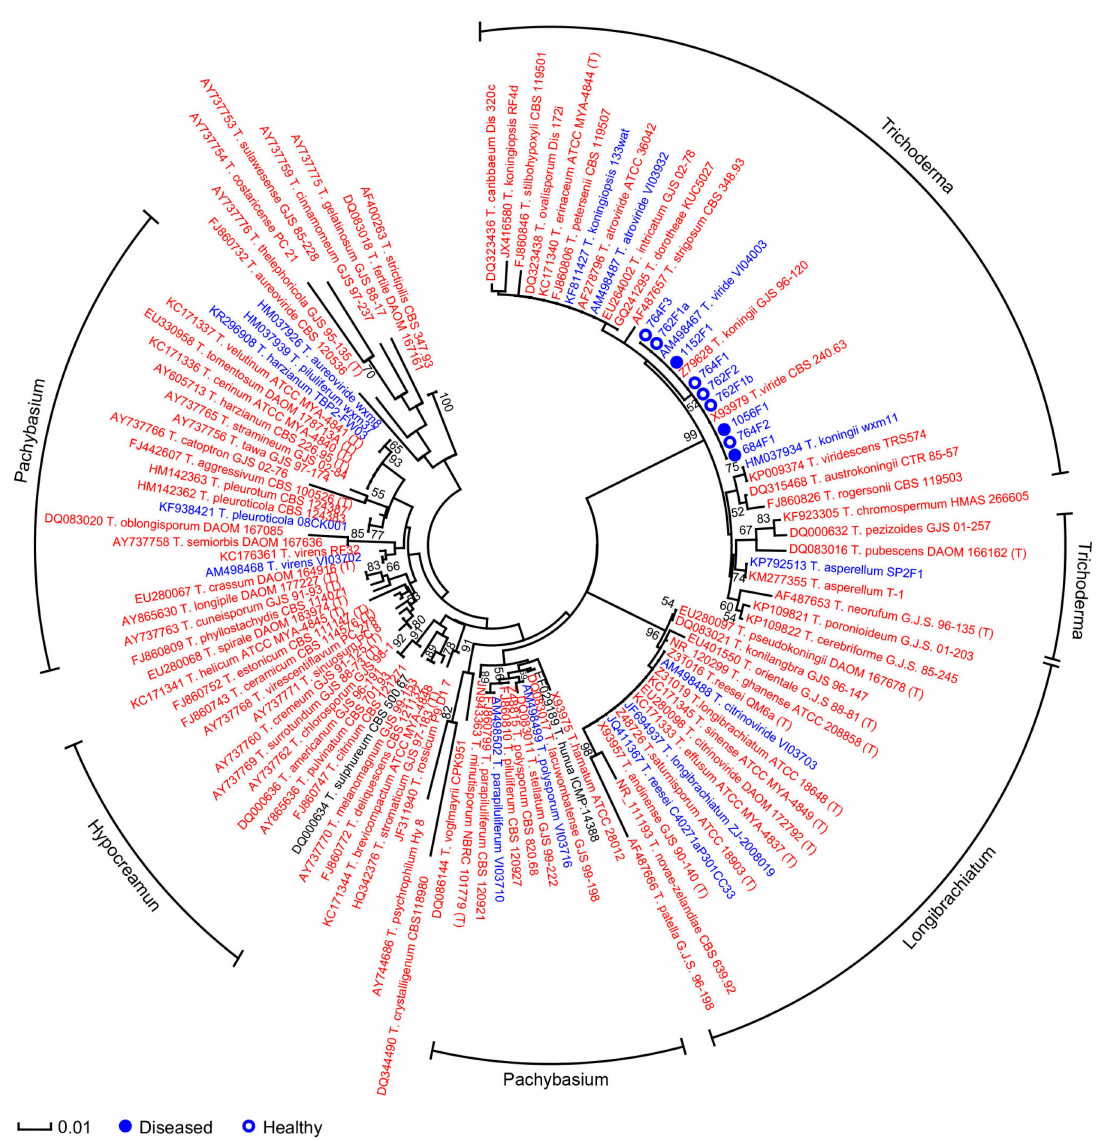
Figure 5. Phylogenetic tree of ITS rRNA sequences of nine Trichoderma isolates and reference strains. The phylogenetic analyses were conducted in Mega 5 using the Tamura 3-parameter method [70] to compute evolutionary distances. The bootstrap values indicated at the nodes are based on 1000 bootstrap replicates. Branch values lower than 50% are hidden. Closed and open circles indicate isolates from Saprolegnia -infected (diseased) or healthy samples, respectively. Red, blue and black colors indicate strains from terrestrial/plant, aquatic and unknown sources of isolation, respectively. The scale bar indicates an evolutionary distance of 0.01 nucleotide substitution per sequence position. Outer labels describe section names based on the list of species in ISTH website [64] and only sections contained at least five strains are indicated. 104 ITS sequences of good quality and at least 550 bp of reference strains of Trichoderma were downloaded from GenBank; their corresponding strain names are preceded by the accession numbers. Strain names followed by “(T)” indicate type